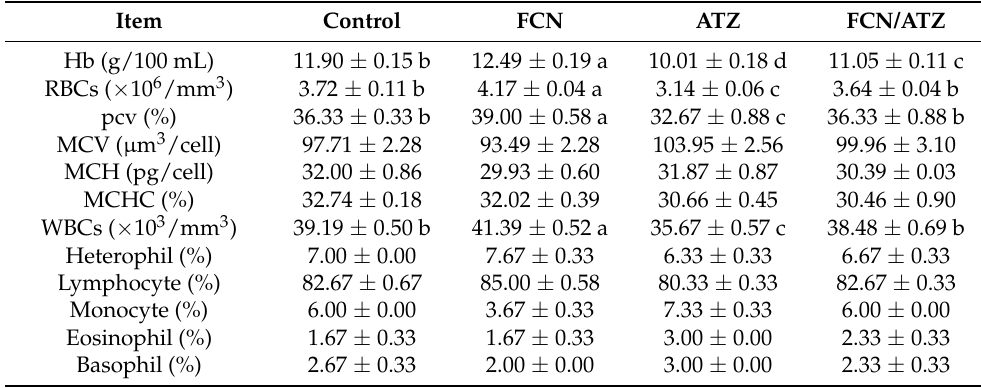
Table 2. Hematological profile of Nile tilapia fed fucoidan and exposed to atrazine. Item